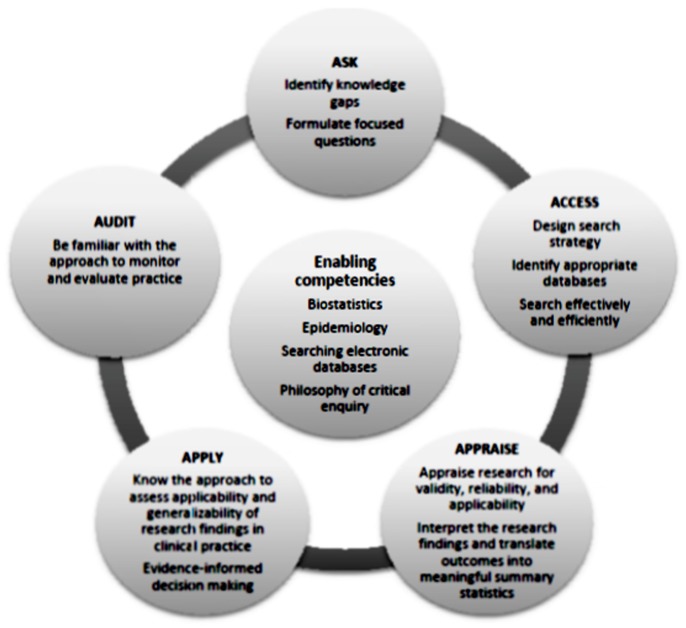
EBHC competencies.